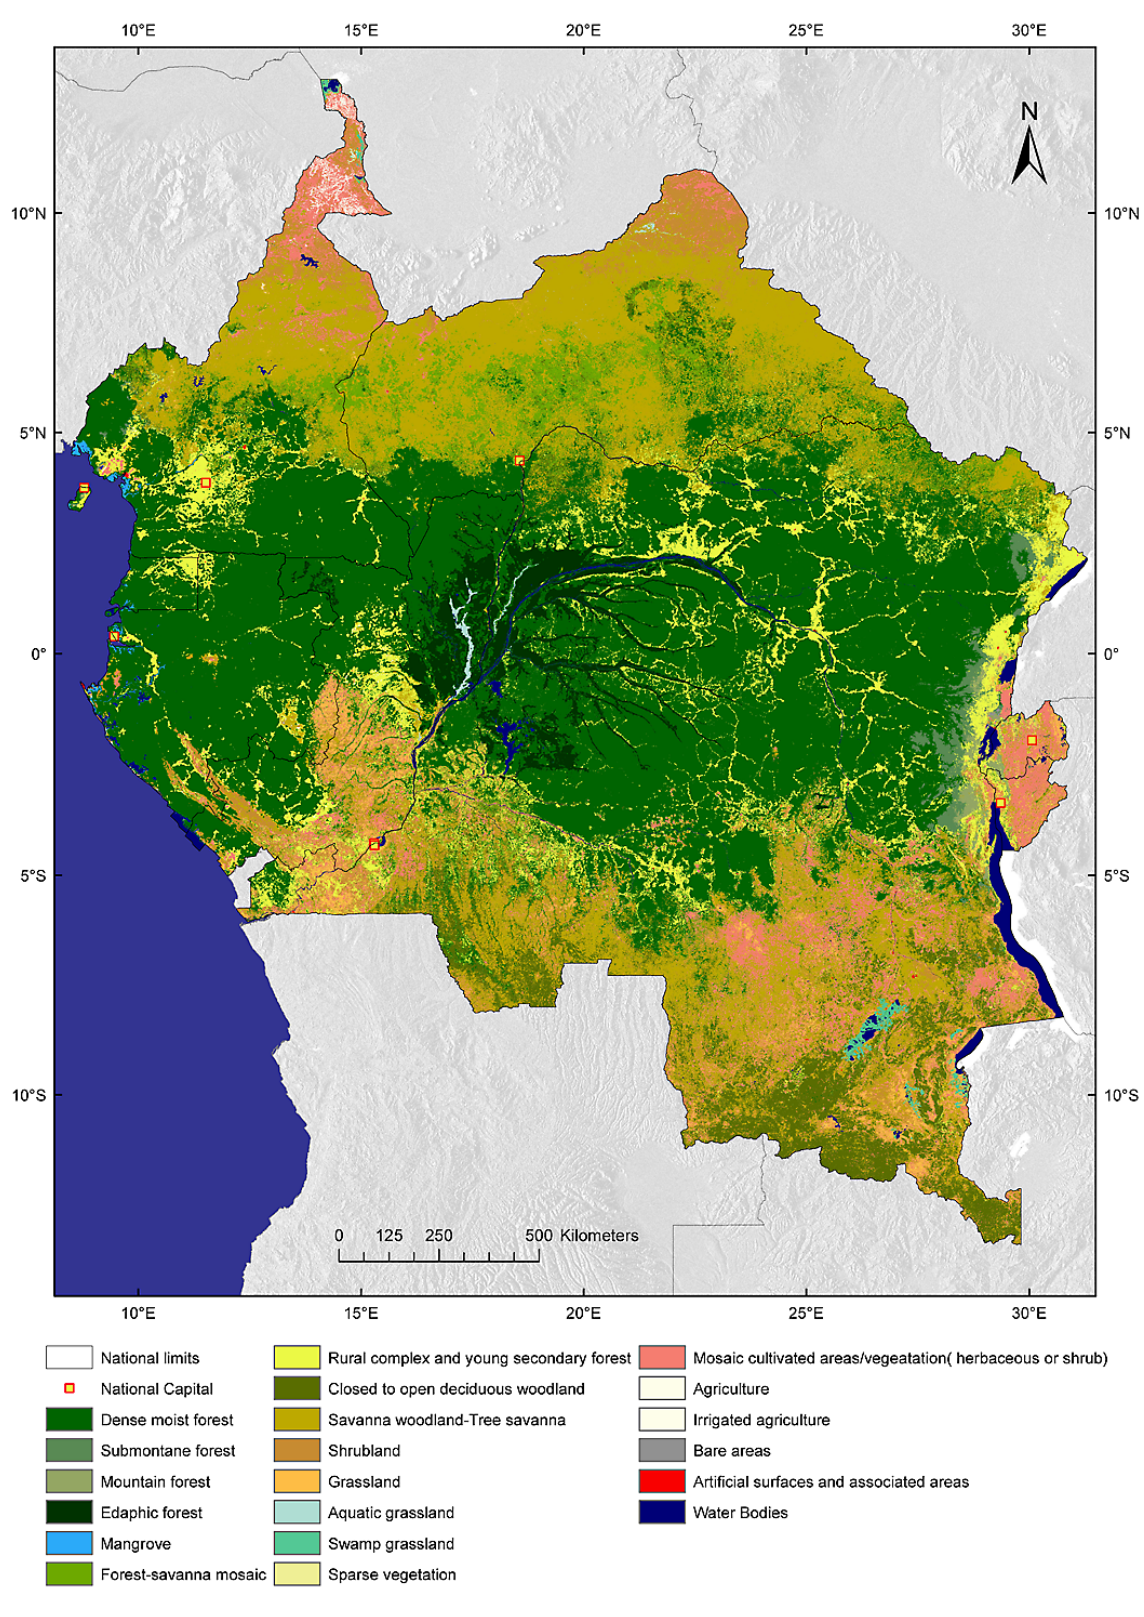
Fig. 3. The Congo Basin vegetation types